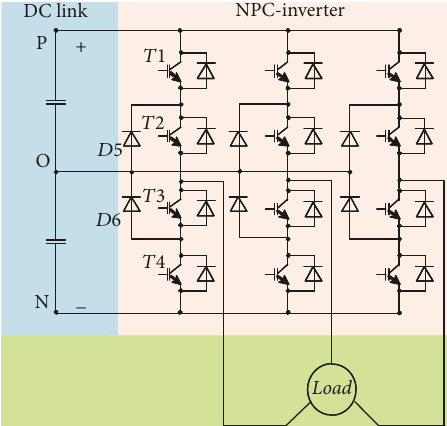
Figure 1: Topology of neutral-point-clamped three-level inverter.